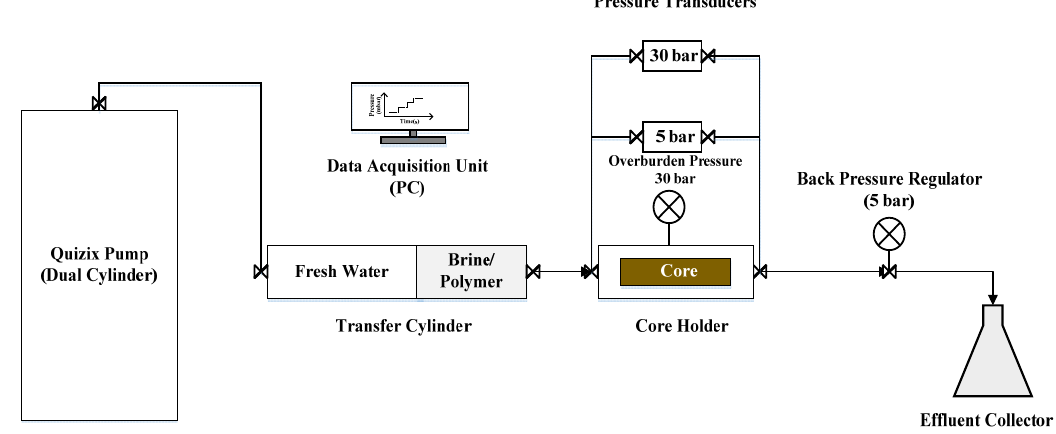
Figure 2. Schematic diagram of core flooding apparatus used for in-situ rheology Figure 2 Schematic diagram of core flooding apparatus used for in-situ rheology experiments.